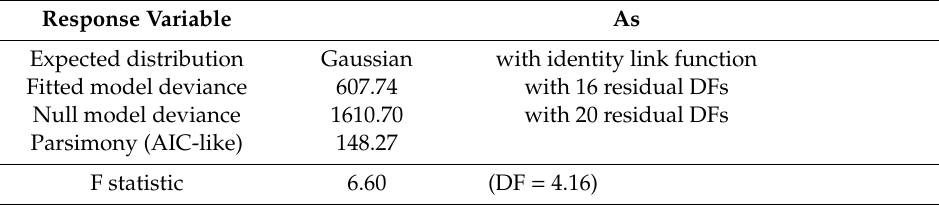
Table 2. Analysis of generalized linear models of heavy metals and arsenic in river water in the Central Andes of